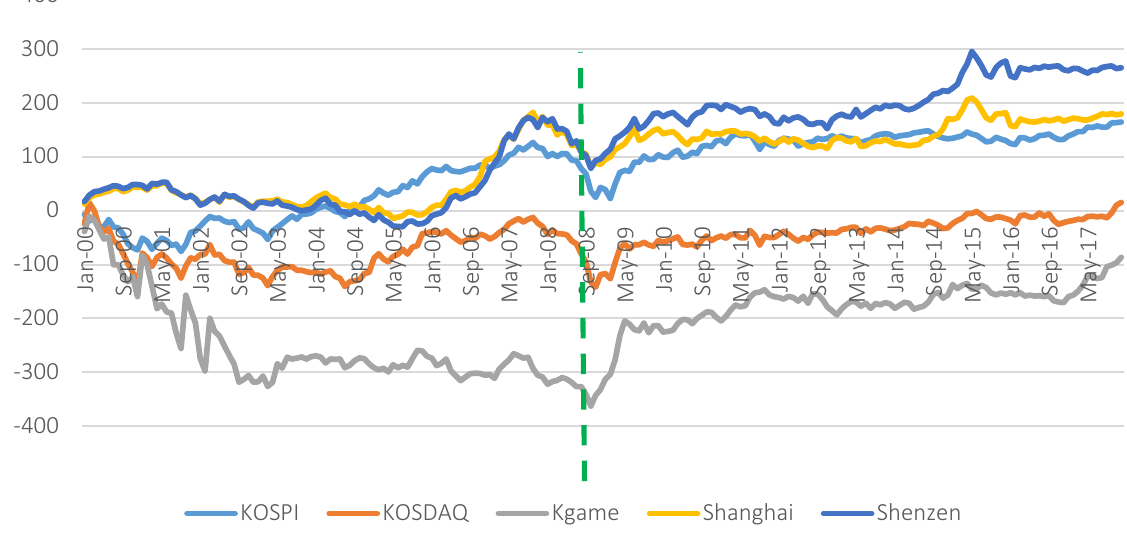
Figure 3. Cumulative returns for KOSPI, KOSDAQ, Shanghai index, Shenzhen index, and Korean game companies’ portfolio